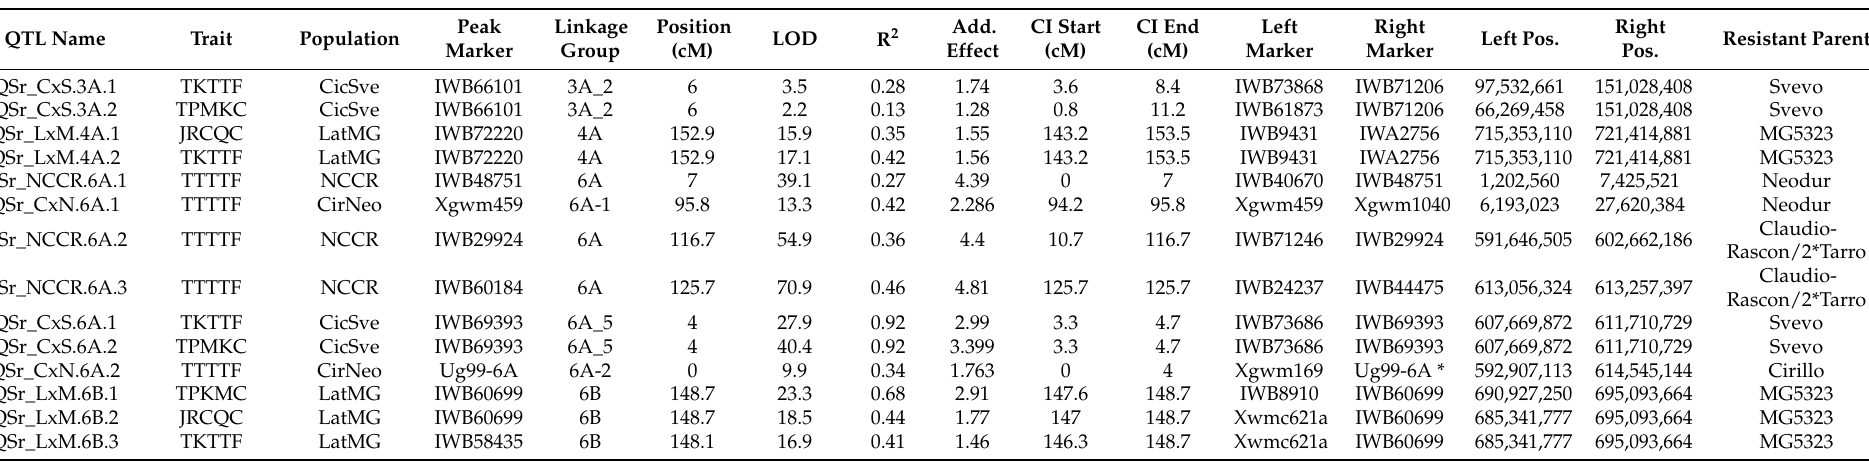
Table 4. QTLs identified in the present study. Add. Effect: additive effect; CI: confidence interval; Left and Right pos. are physical position of left and right marker on the durum wheat reference genome of Svevo. * For QSr_CxN.6A.2 the physical position of the left end was estimated based on other markers present in the region, as the Ug99-6A marker was a phenotypic marker related to resistance to race TTKSK